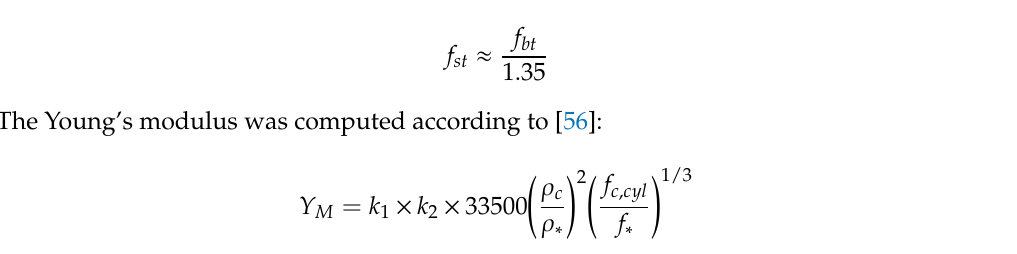
Figure 3. ( a ) Overview and ( b ) cross section of the Runcahez SBT (position 46°40’45.0” N 8°58’05.7” E; adapted from [18] ).